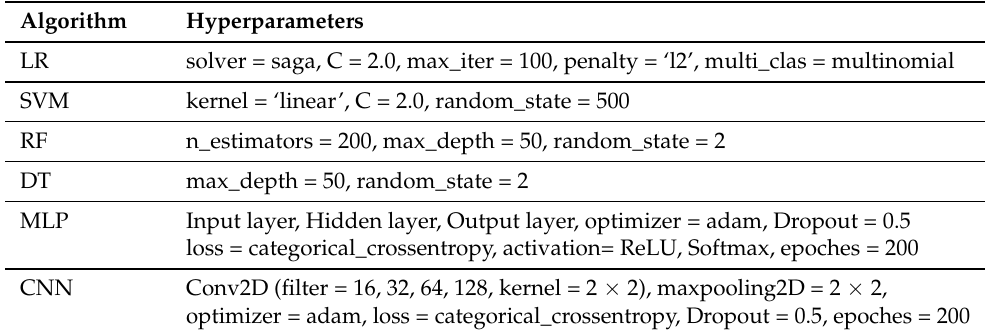
Table 2. Hyperparameters that are fine-tuned to optimize the performance of the machine learning models. Algorithm